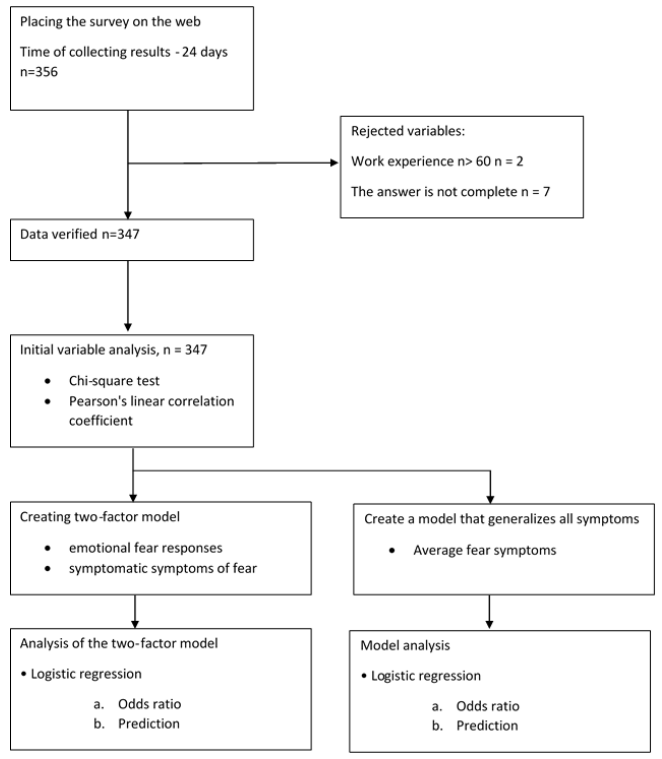
Figure 2. Flow diagram — the study population (respondents) and the statistical methods using.